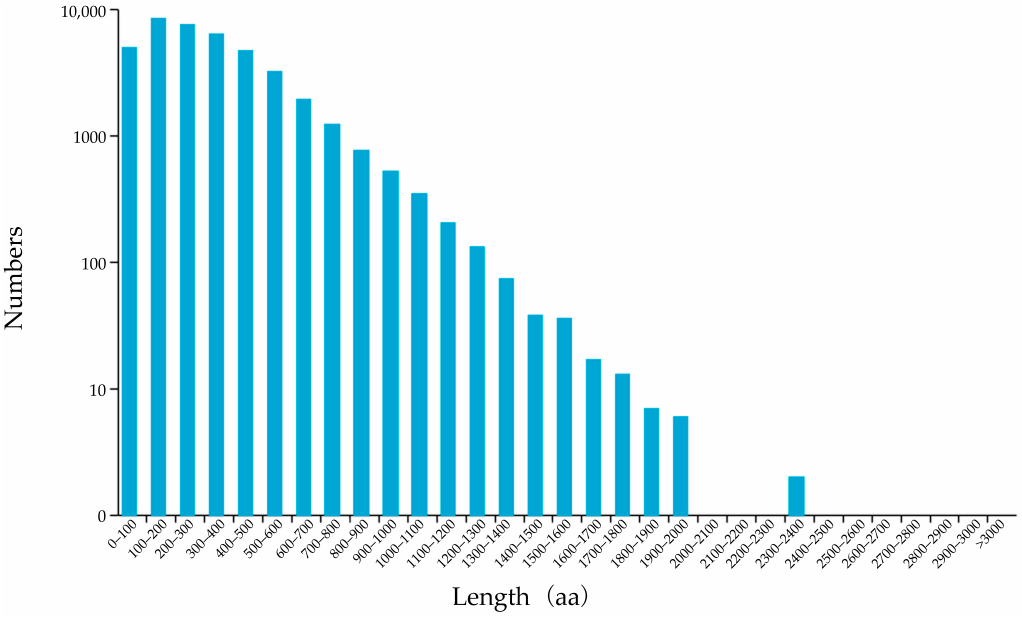
Figure 4. The predicted length distribution of the protein encoded by the complete